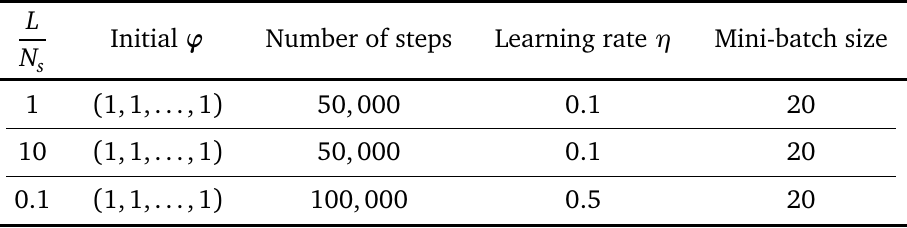
Table 1: The parameters used in the mini-batch gradient